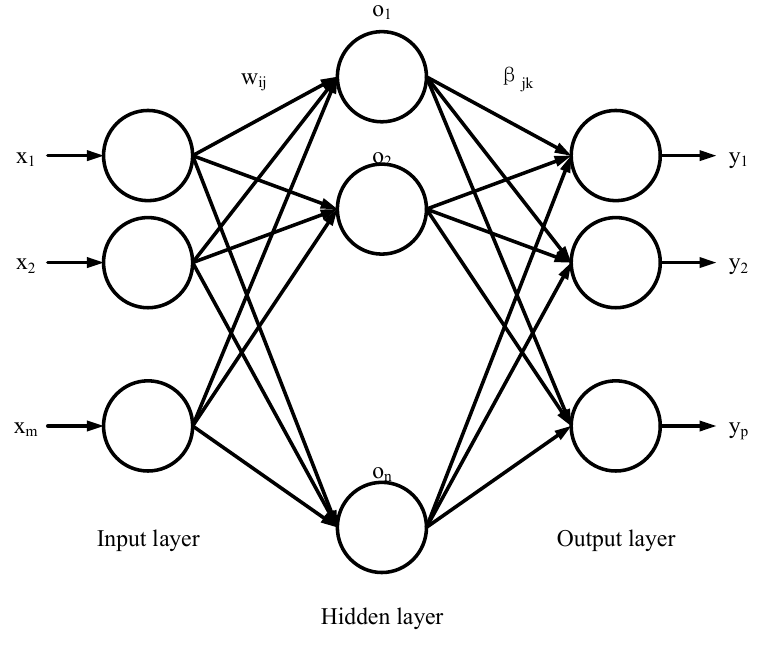
Figure 1. The structure of ELM model.